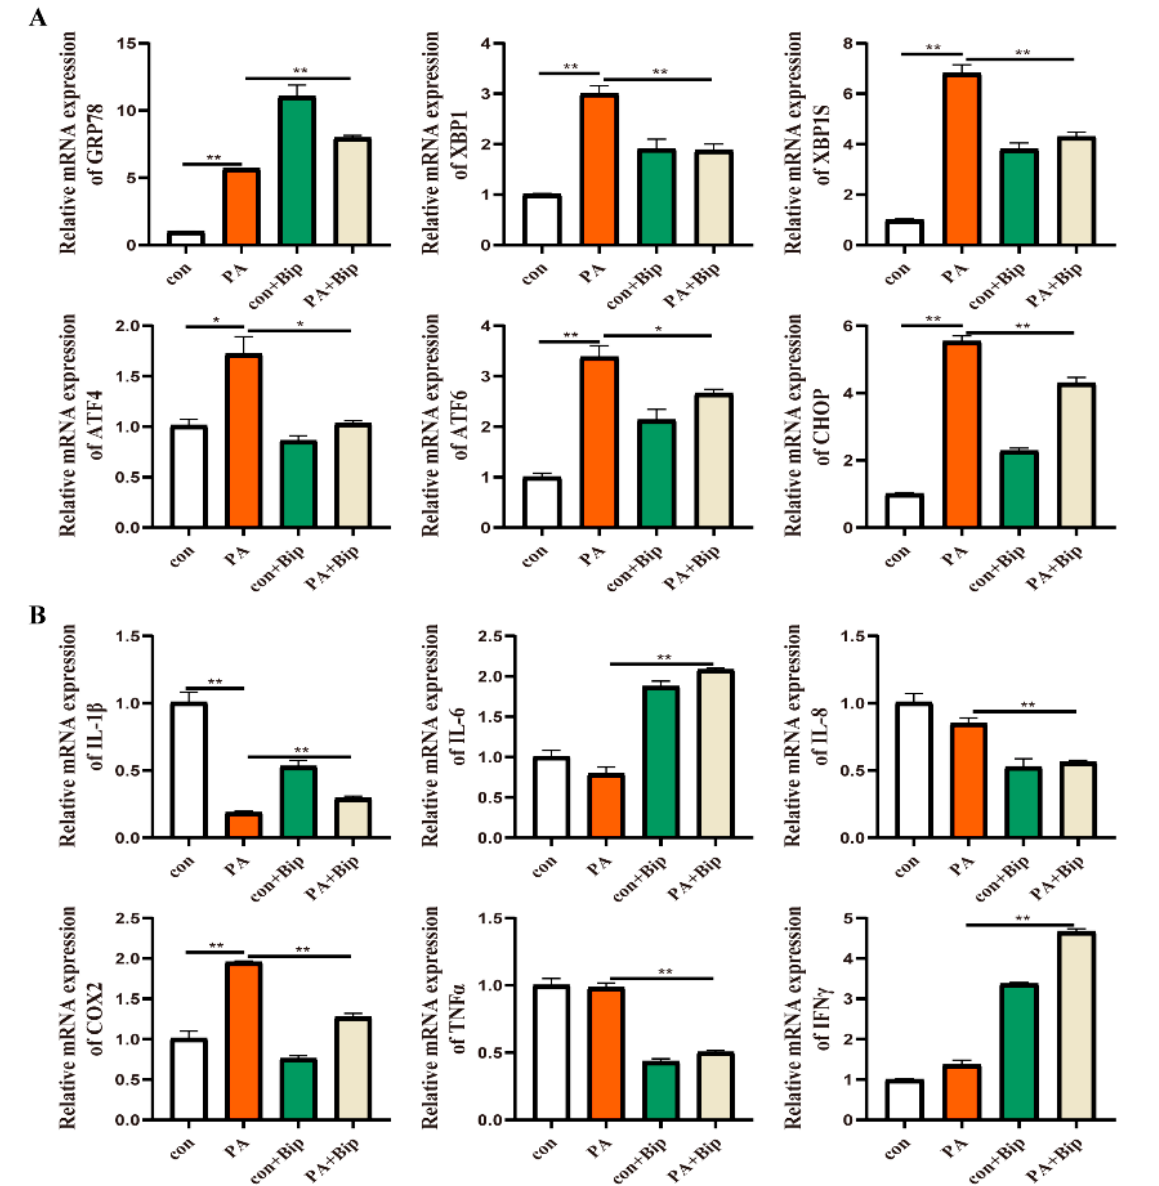
Figure 10. Effects of 10 µ M BiP treatment for 4 h after 500 µ M PA incubation for 6 h on ER stress and inflammation in macrophages of large yellow croakers. ( A ) Relative mRNA expression of ER stress-related genes. ( B ) Relative mRNA expression of inflammatory genes. Values are presented as mean ± SEM ( n = 3). * Significant difference ( p < 0.05); ** highly significant difference ( p < 0.01).